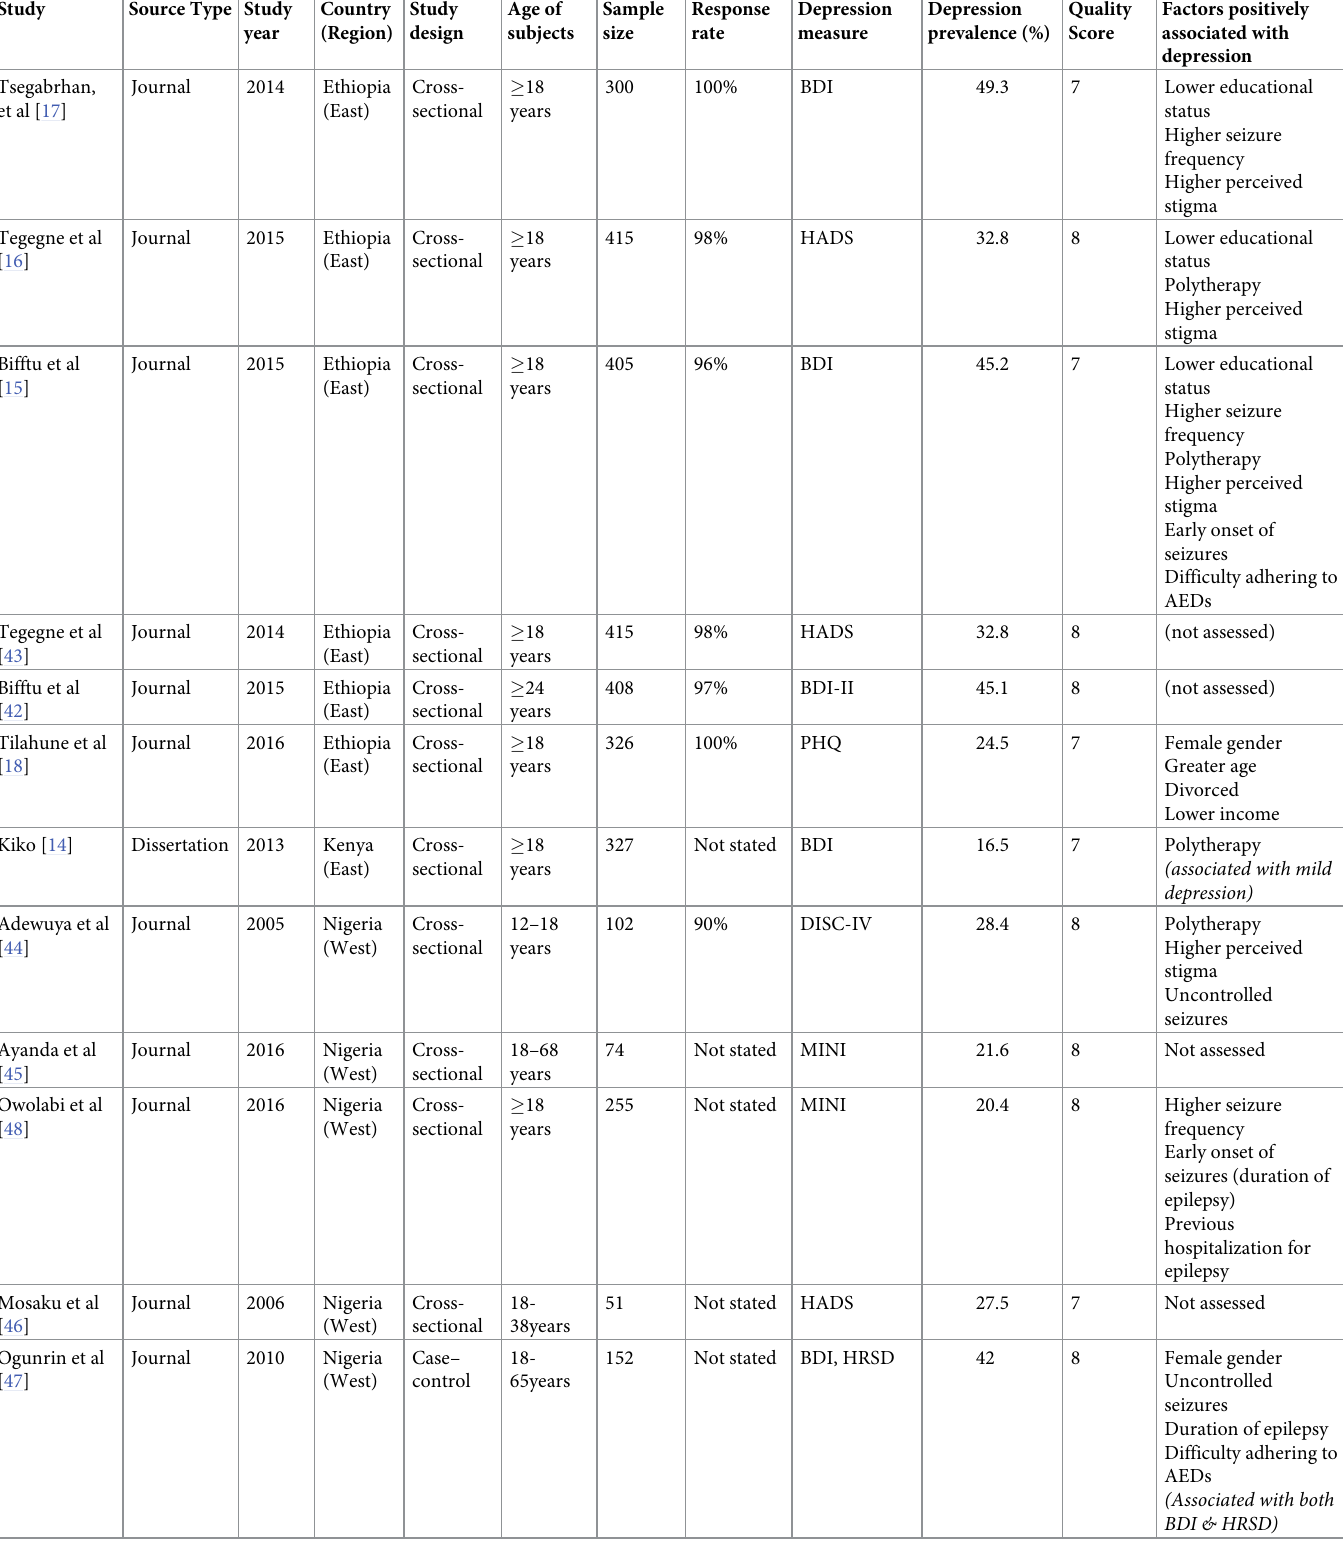
Table 1. Characteristics of included studies for systematic review and meta-analysis, 2005–2017, sub-Saharan